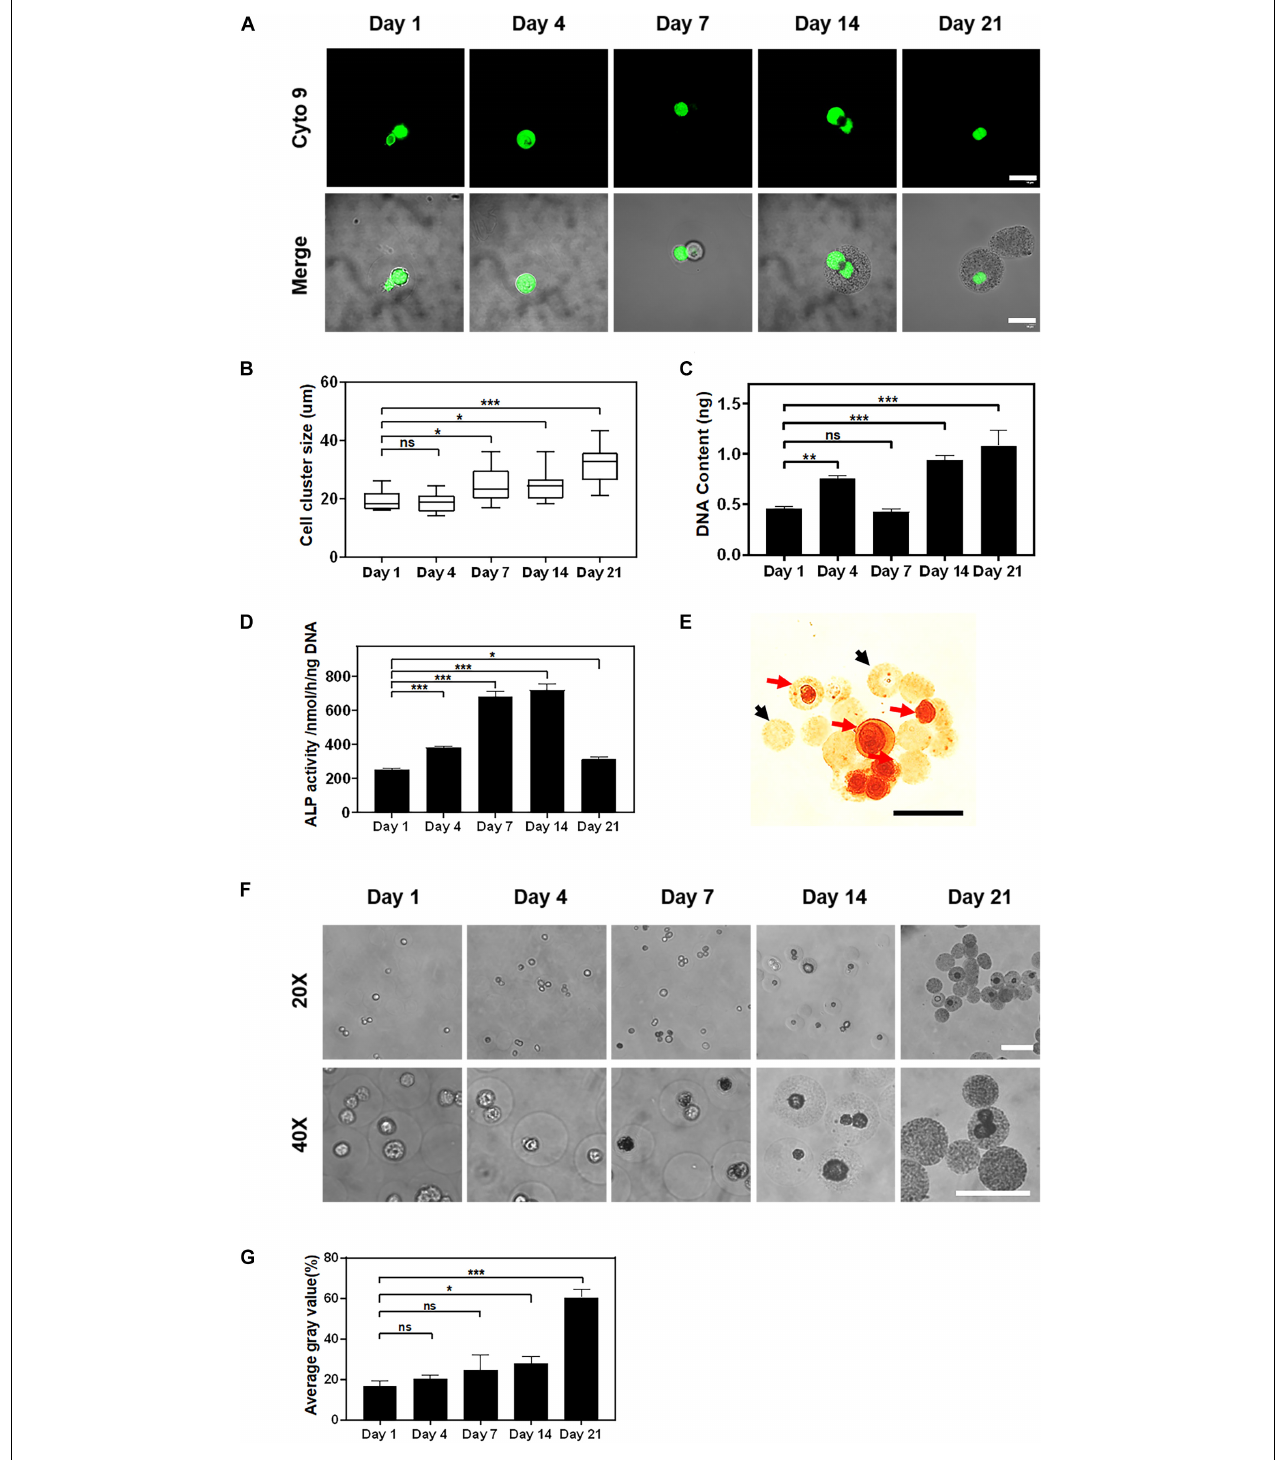
FIGURE 5 | The proliferation and osteogenic differentiation of stem cells encapsulated in alginate using the Ca-NTA complex. (A) Confocal microscopic images of MSCs encapsulated in alginate microgel after SYTO 9 nucleus staining (green). Scale bar is 20 µ m. (B) Quantify the average diameter of cell clusters within the microgels at different time points using ImageJ. (C) The cell proliferation was further determined by the DNA content. (D) Osteogenic differentiation of MSCs was measured by ALP activity at different time points. (E) Cell-laden microgels were stained with 1% Alizarin Red S. The black arrow indicated microgels without cells, and the red arrow indicated cell-laden microgels. (F) Light microscopic images of microgels under the phase contrast microscope, and (G) the mineralization of the cell-laden microgels was determined based on the average gray value of microgels. Scale bar is 100 µ m (ns > 0.05, * p < 0.05, ** p < 0.01, *** p < 0.001).